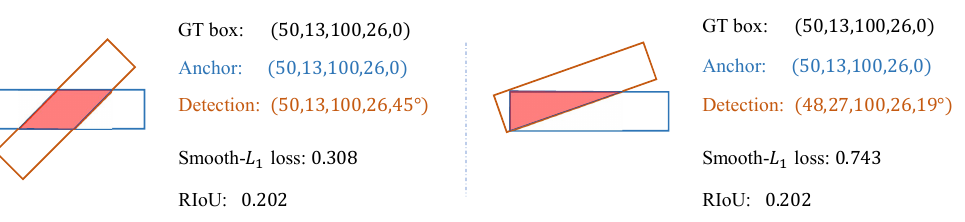
Figure 5. Examples of inconsistency between smooth-L 1 loss and localization accuracy. The two detection boxes with the same rotated IoUs have different losses, which leads to a suboptimal optimization process for